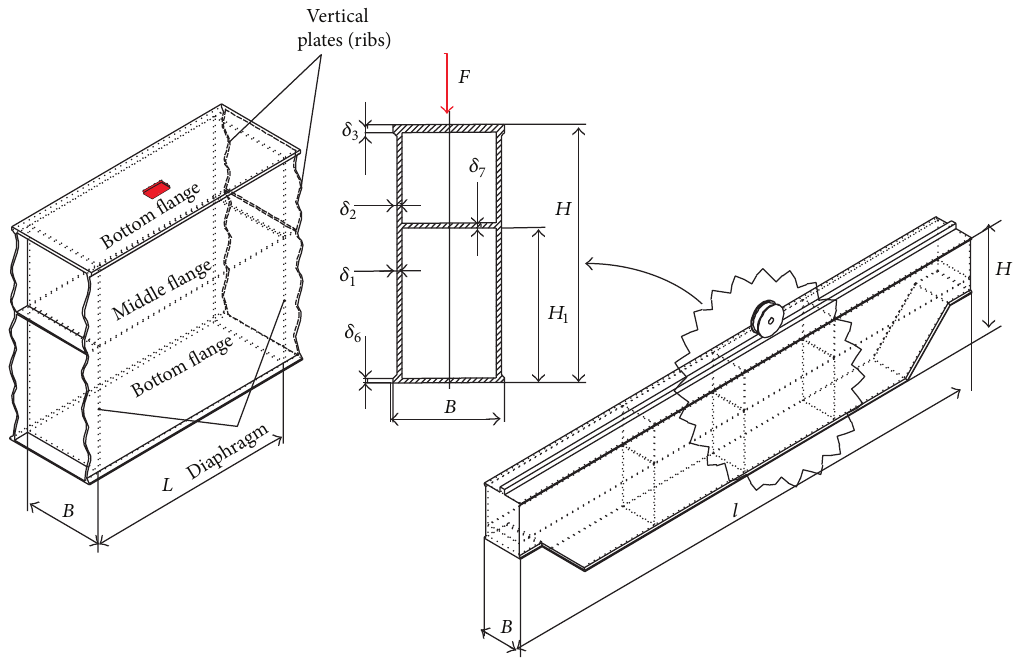
Figure 1: Structure and load of the two-cell box